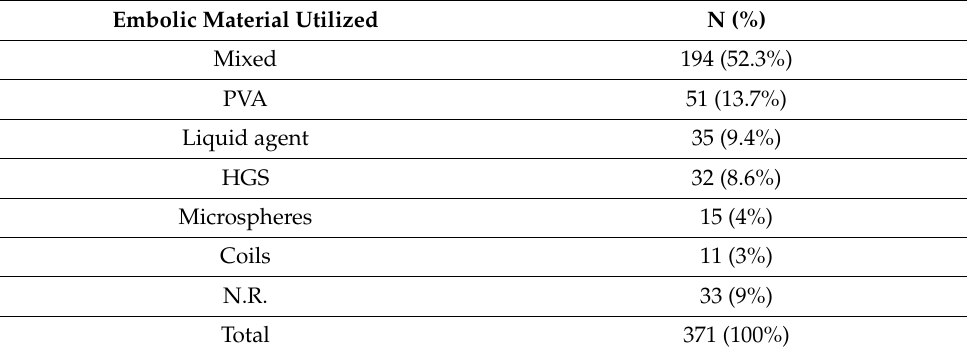
Table 2. Embolic material utilized in the studies